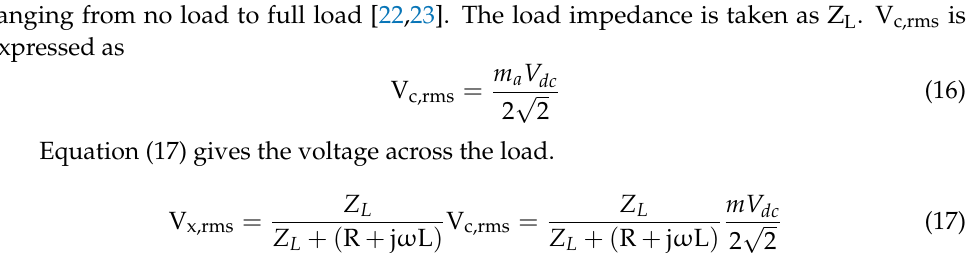
(d) Figure 5. Control for ( a ) active power, ( b ) reactive power, ( c ) DC voltage control, and ( d ) DC voltage control. The reactive power is given by Q (cid:2914)(cid:2927) = (cid:2879)(cid:2871) (cid:2870) V (cid:2934)(cid:2914) i (cid:2927) and is controlled by reactive current i q. i qref is limited to +/ − Iq-max such that I max = I rated . Hence, i (cid:2927)_(cid:2923)(cid:2911)(cid:2934) = (cid:3495)I (cid:2923)(cid:2911)(cid:2934) (cid:2870) − i (cid:2914)(cid:2928)(cid:2915)(cid:2916) (cid:2870)